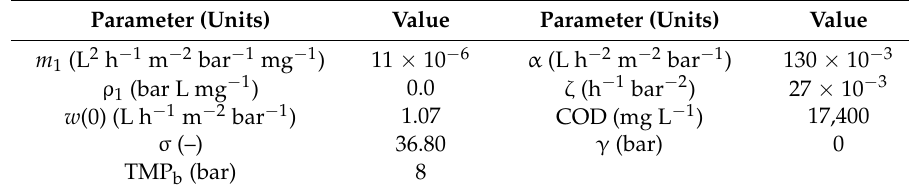
Table 1. Input values for the simulation code. COD: chemical oxygen demand.